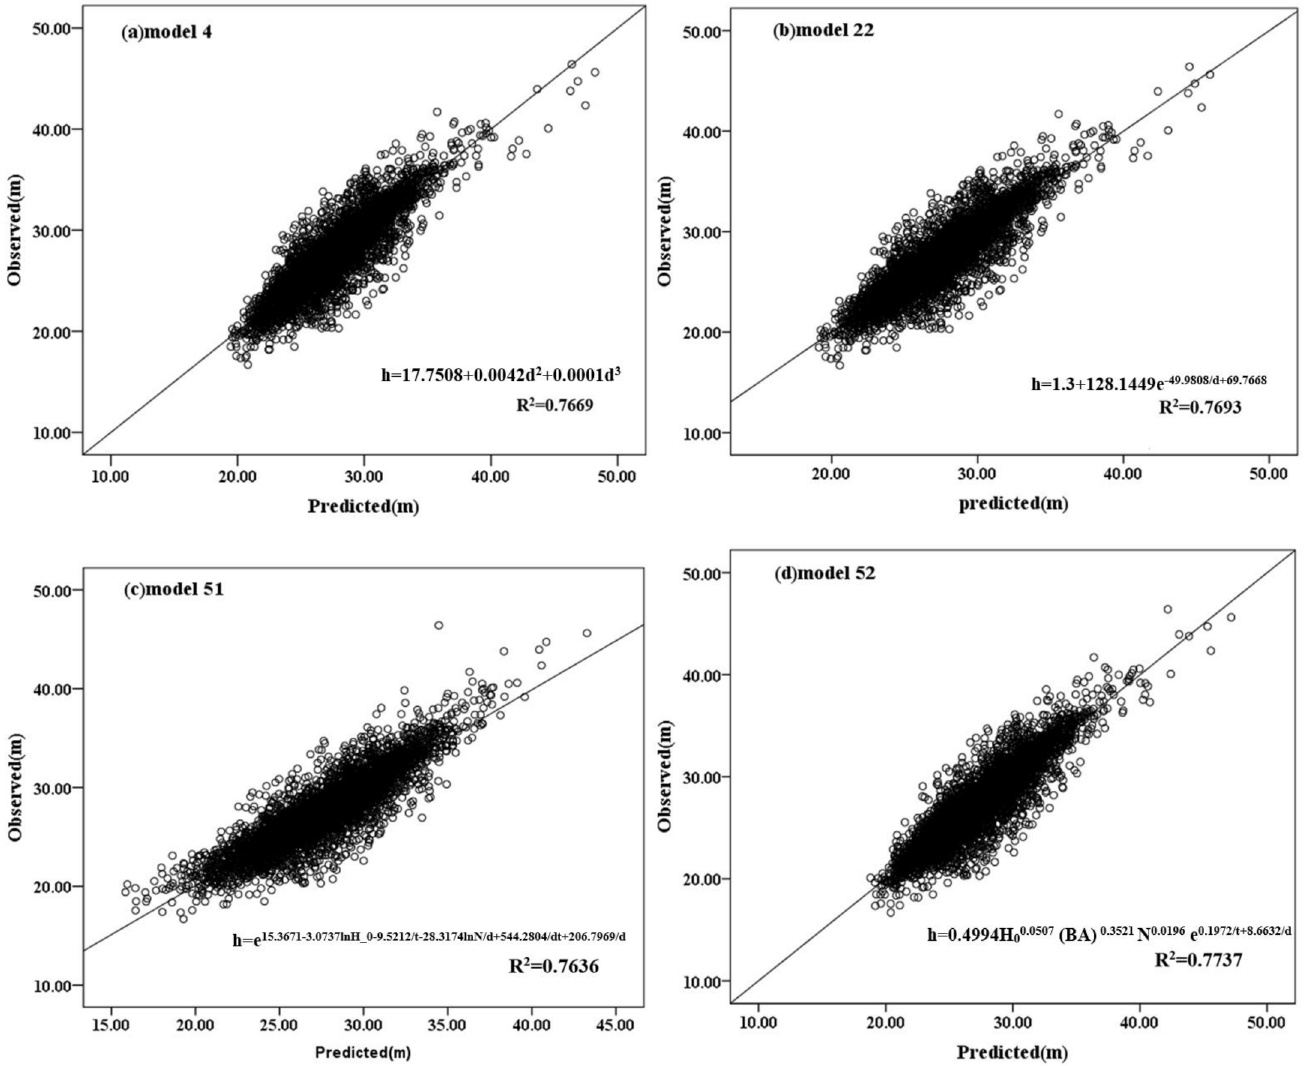
Fig 3. Graph of predictedvalues in contrast to observedvalues in the calibrationdataset for the three best models (a: Model 4; b: Model 22; c: Model 51; d: Model 52). The solid line represents the diagonal.doi: 10.6084/m9.figshare.4956284.g003.